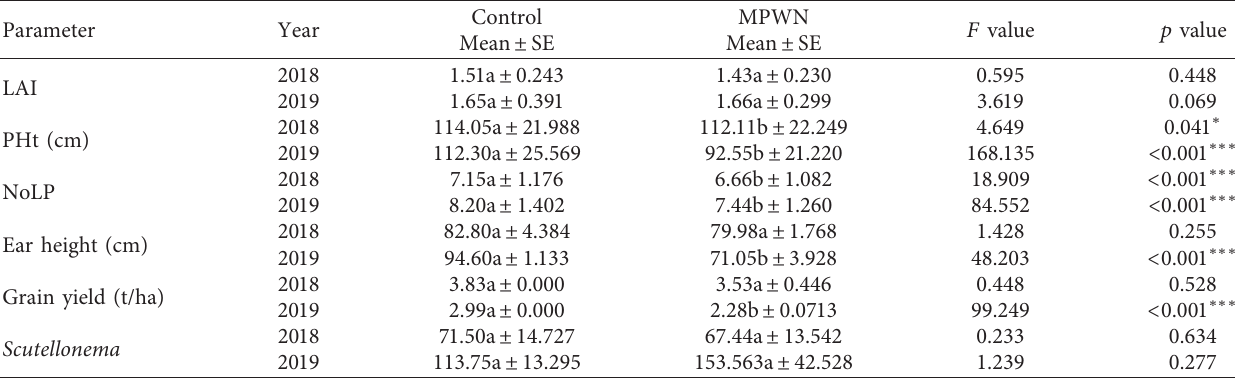
Table 3: Leaf area index (LAI), plant height (PHt), number of leaves per plant (NoLP), main ear height, grain yield, and Scutellonema density in control plots (treated with nematicide) and MPWN (maize plots with no nematicide) during trial one (2018) and trial two (2019) in Nyangati study site, Mwea subcounty.